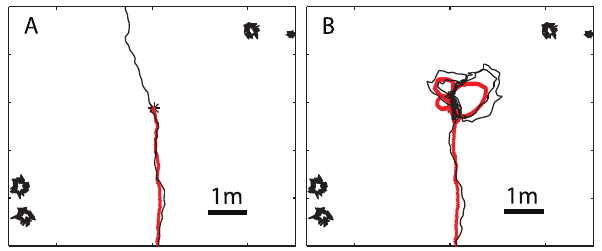
Figure 2. Including learning walks prevents return paths from overshooting the goal. A) Without a learning walk the simulated ant overshoots and carries on in the direction it was heading as it approached the nest location. B) By including the views experienced during a learning walk the simulated ant, instead of overshooting, gets repeatedly drawn back to the location of the nest. Red lines training paths, black lines recapitulations.